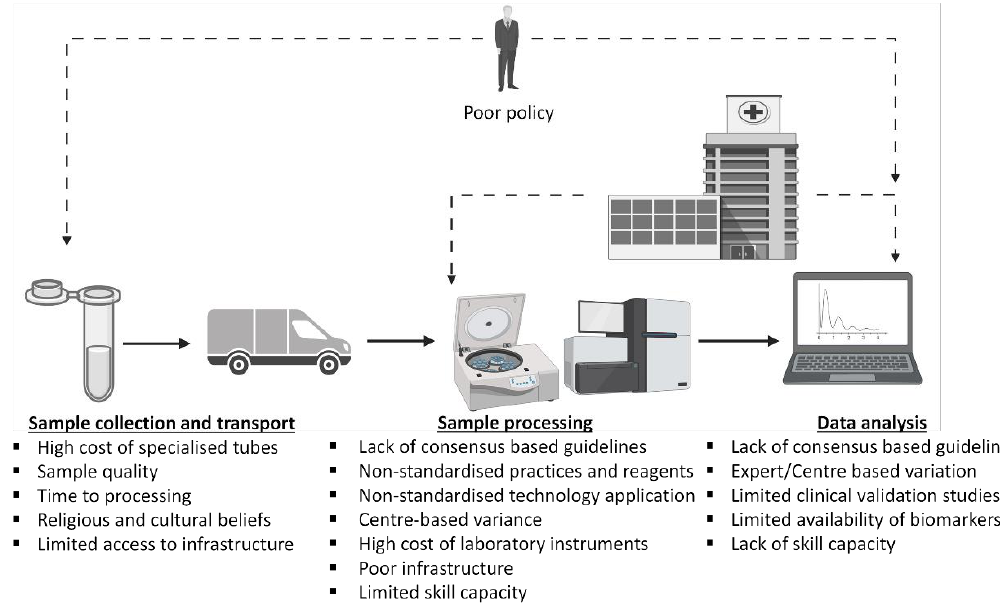
Figure 1. Challenges associated with the implementation of liquid biopsy in poorly resourced settings. Created in BioRender.com, accessed on 21 July 2021) .